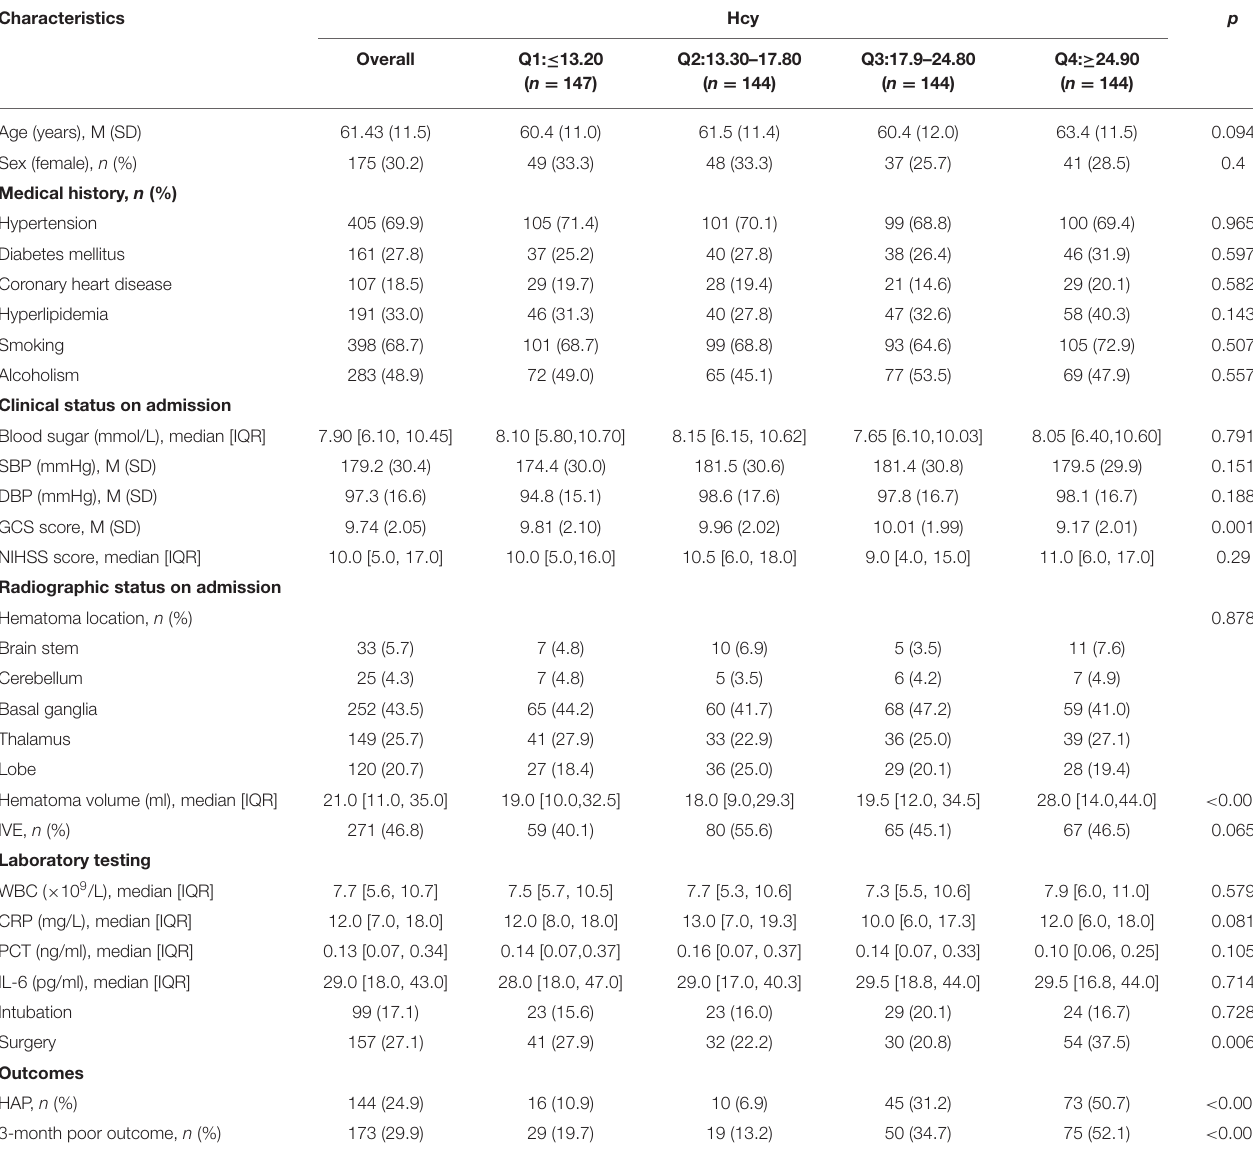
TABLE 1 | Baseline characteristics of participants according to Hcy